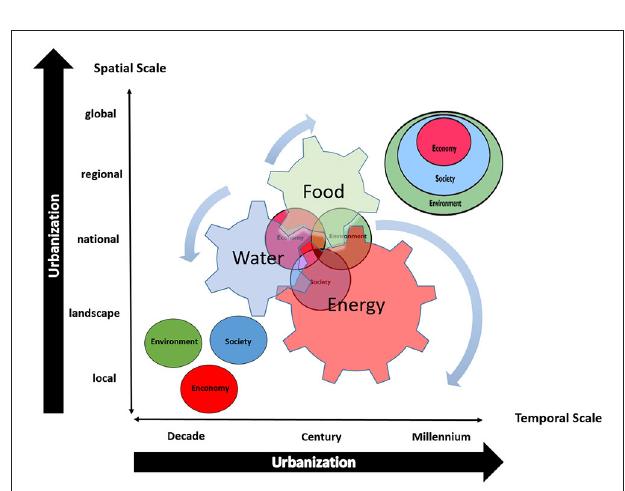
FIGURE 6 | The Transitioning Urban Socio-Ecological Nexus across spatial and temporal scales and levels under the primary driver of urbanization. This schematic diagram can be used to illustrate the integrated spatial and temporal transitions from unconnected to an interdependent/nested urban food-energy-water nexus in the contexts of urbanization and the associated social, economic and environmental complexities and innovations.